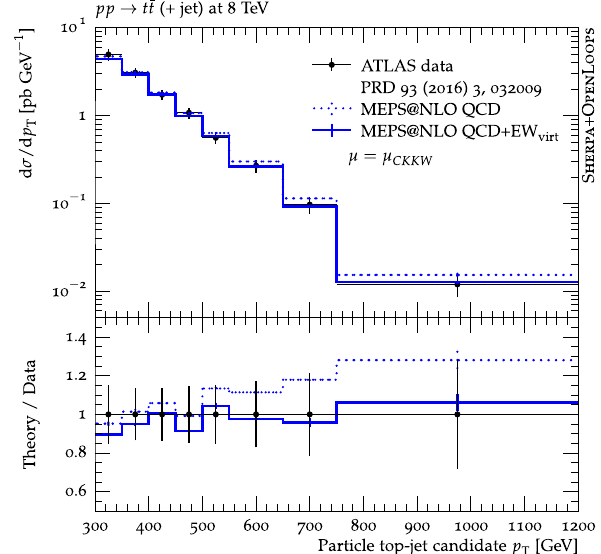
Fig. 5 ComparisonoftheMEPS@NLOQCDandMEPS@NLOQCD + EW virt predictions for the transverse momentum distribution of hadronically decaying top candidates against an 8 TeV ATLAS mea- surement in the lepton + jets channel based on a boosted top selection